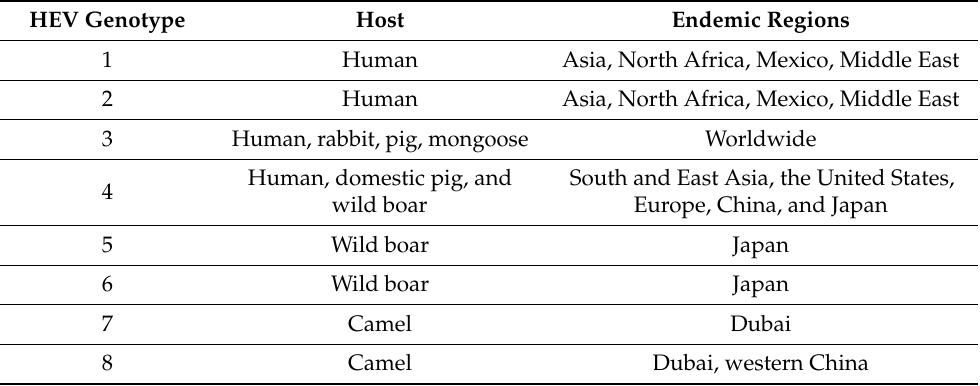
Table 2. Distribution of HEV